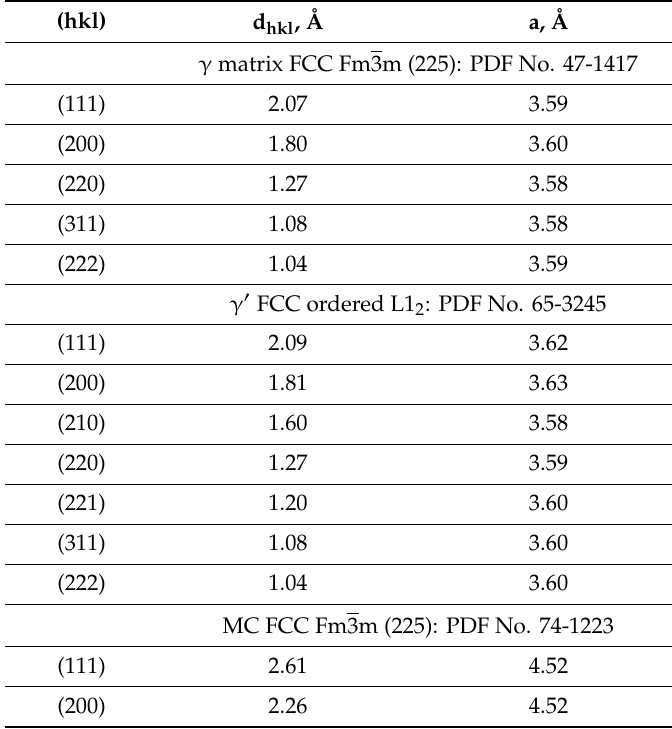
Figure 1. XRD pattern of René 108 (Co K α radiation), λ = 1.79 Å. Table 3. The measured values of d hkl spacing and lattice parameters for γ , γ ', MC carbides in the René 108.